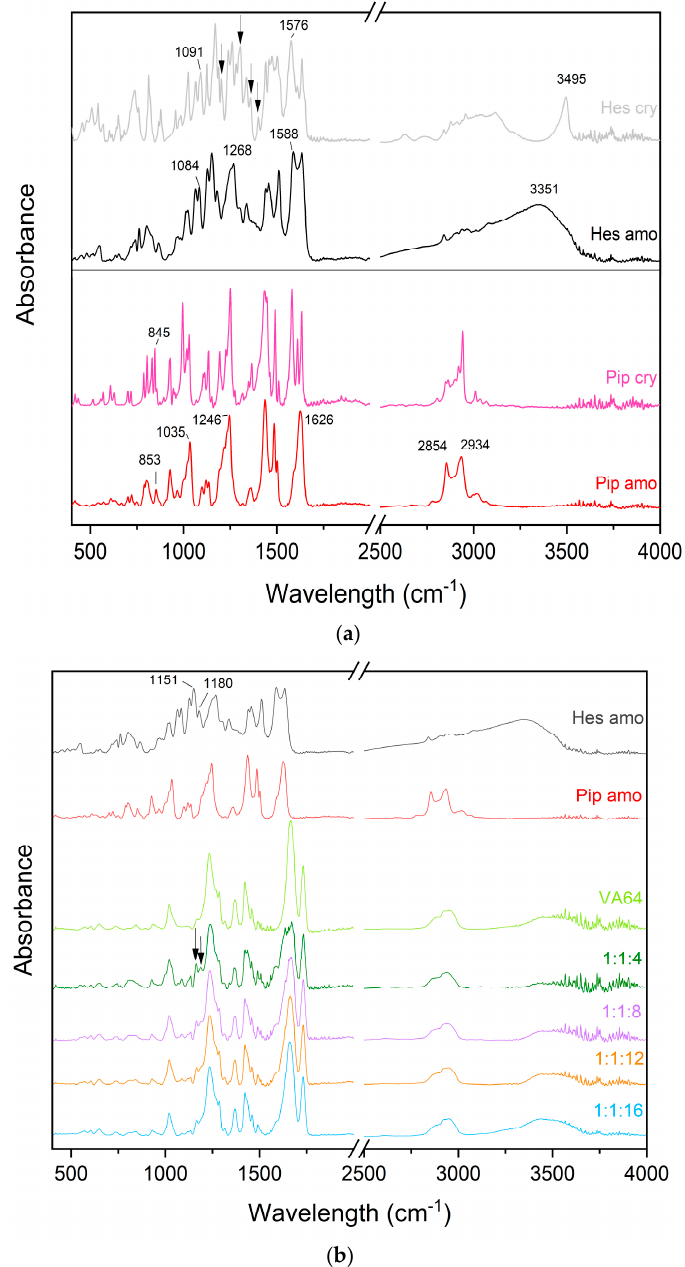
Figure 3. FTIR-ATR spectra of raw hesperetin and piperine in crystalline and amorphous forms ( a ), as well as amorphous raw compounds, Kollidon VA 64, and amorphous systems ( b ). Amorphous systems were named as a mass ratio of individual components, Hes:Pip:VA 64 (Hes: hesperetin, Pip: piperine, and VA 64: PVP VA 64). Black arrows indicate changes.